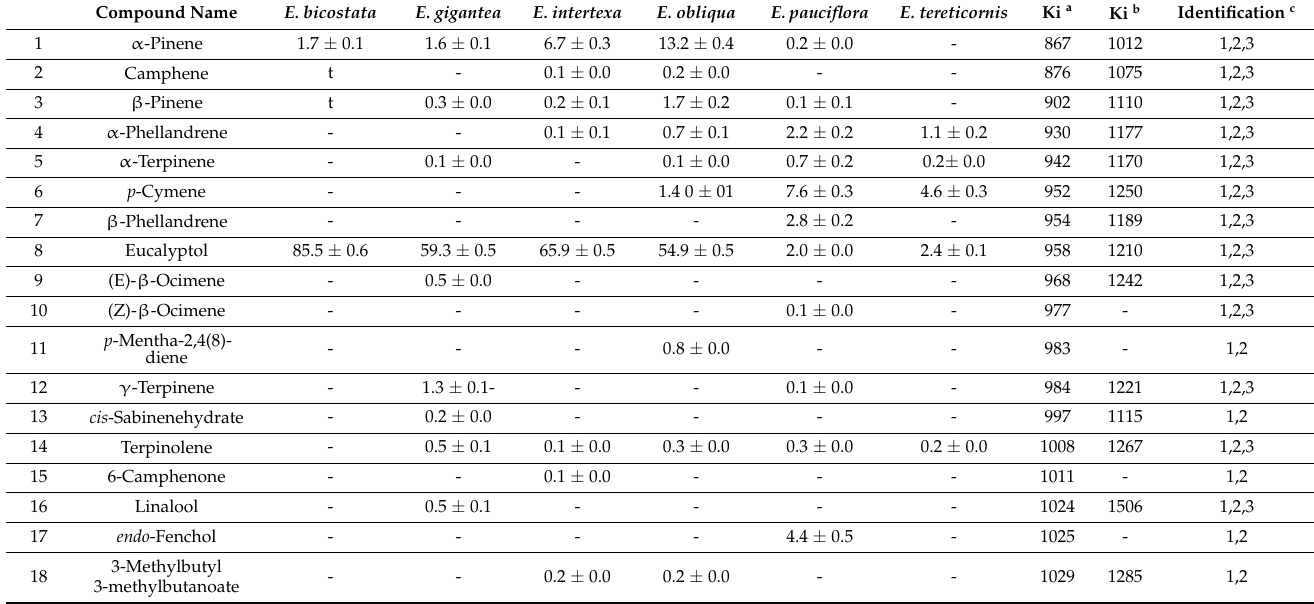
Table 1. Chemical composition (%) of the